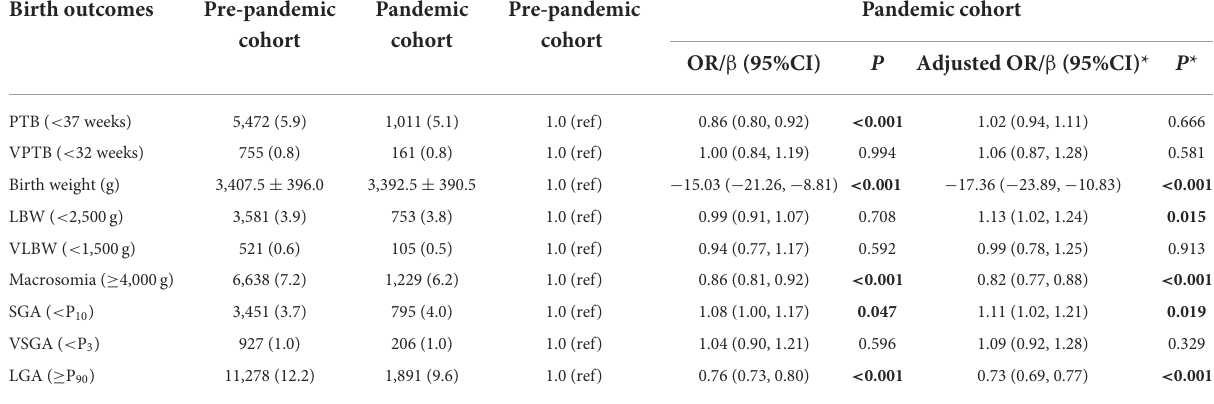
TABLE 2 The association between COVID-19 pandemic and birth outcomes. Birth